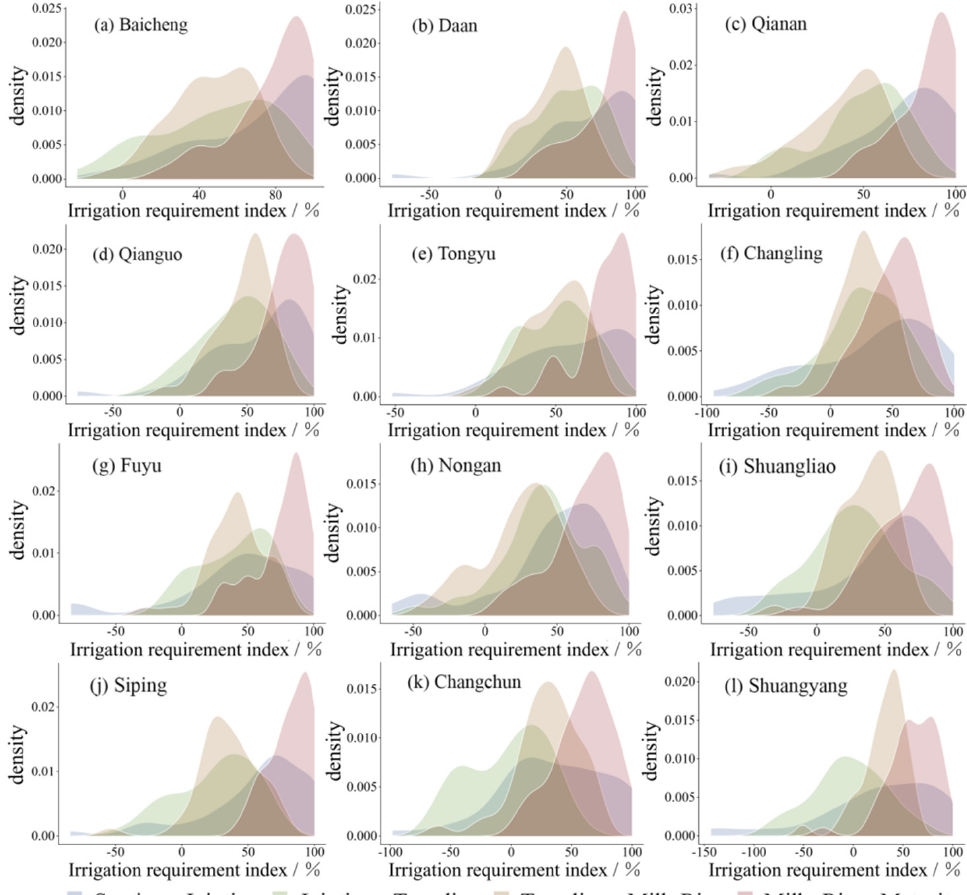
Figure 8. Density distribution of the IRI in maize at different growth period. Geographically (Figure 9), the eastern and central regions have a strong demand for irrigation, with a smaller IRI in the southwest.